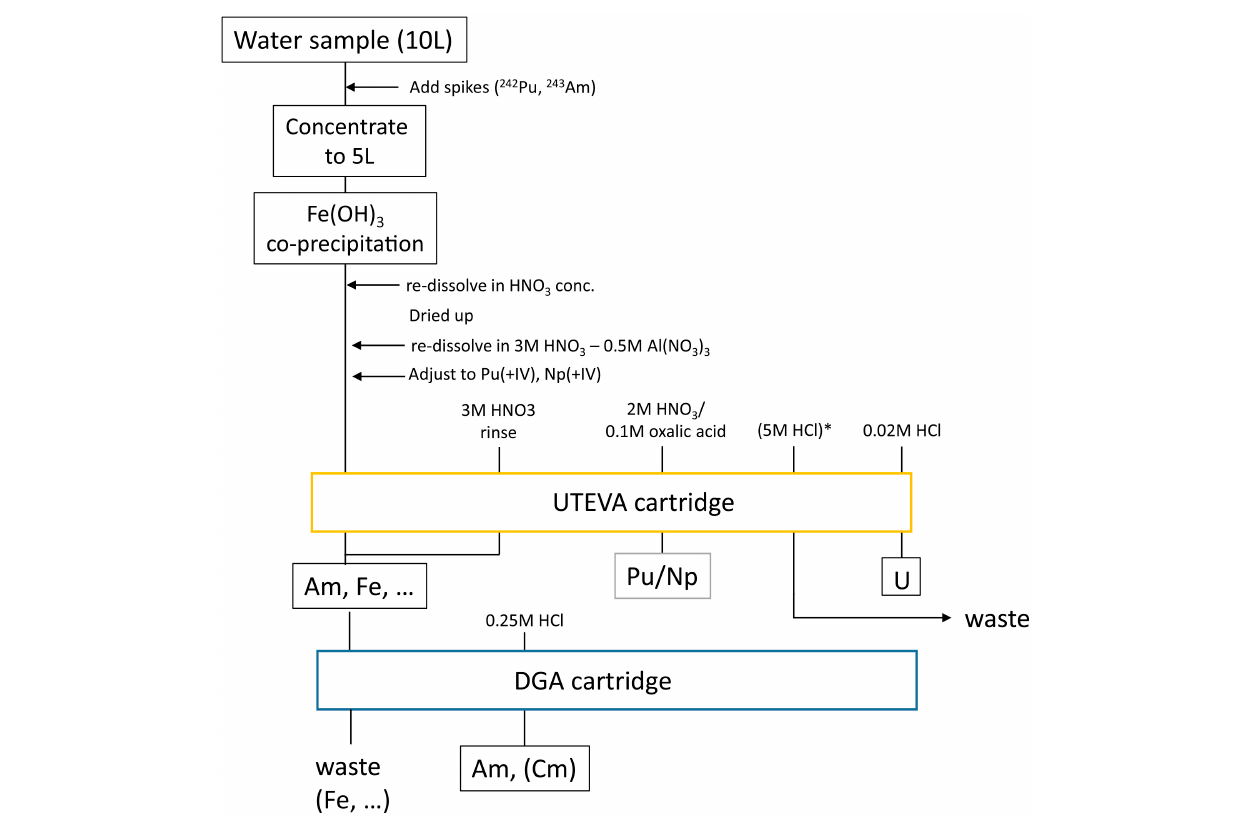
FIGURE 1 | Flow chart of applied separation chemistry to extract and purify Pu/Np, U, and Am from large volume ocean water samples using extraction chromatography. ∗ marks a rinsing step to remove Th in the final U fraction which is only required when 233 U is to be